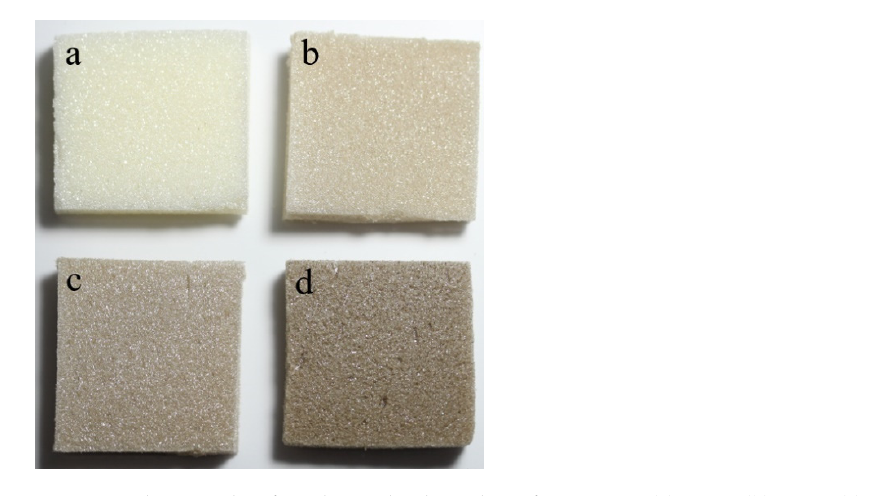
Figure 12. Cell morphology structure of neat polyurethane foam ( a ) and biopolyurethane foam ( b ).